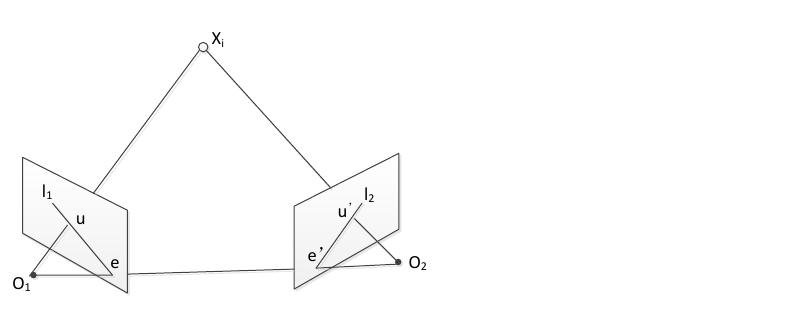
Figure 1. Two-view stereo to demonstrate the epipolar